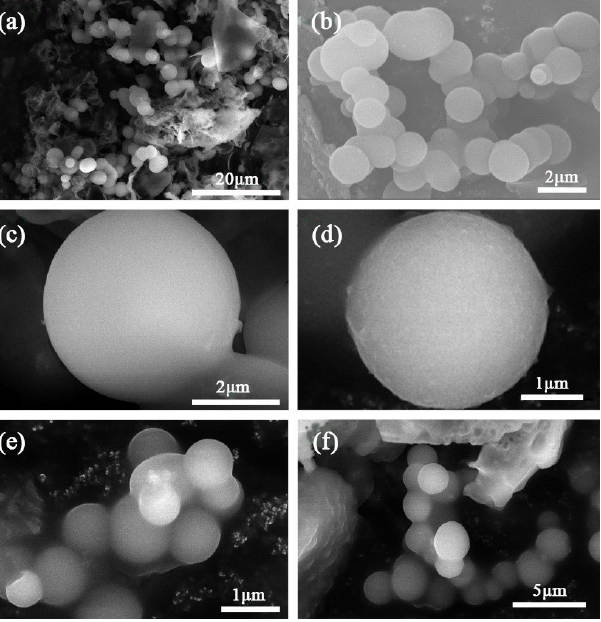
Figure 4. SEM micrographs of ( a – c ) paraffin@SiO 2 microcapsules, ( d – f ) the paraffin@SiO 2 colored microcapsules.